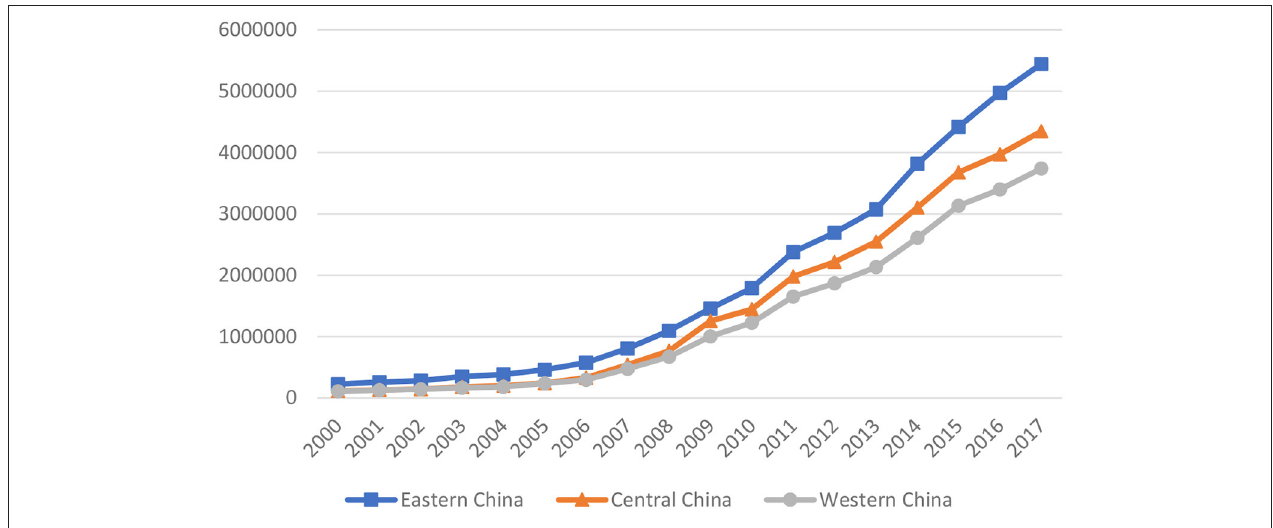
FIGURE 1 | Average medical and health expenditures in eastern, central, and western China from 2000 to